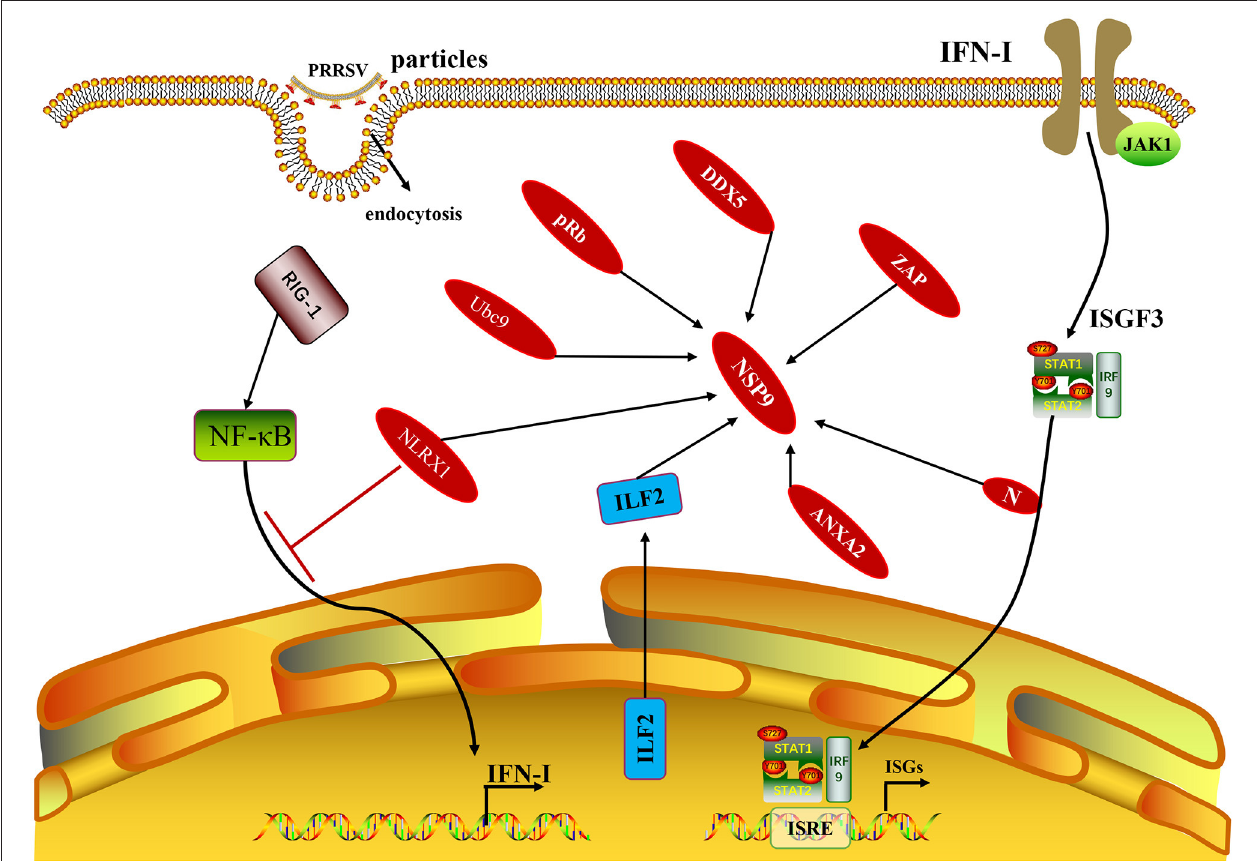
FIGURE 3 | The NSP9 of PRRSV and non-structural proteins with host proteins mentioned in this paragraph. In addition to the host protein, it is also shown that the N protein related to the production of IFN-I also interacts with NSP9.